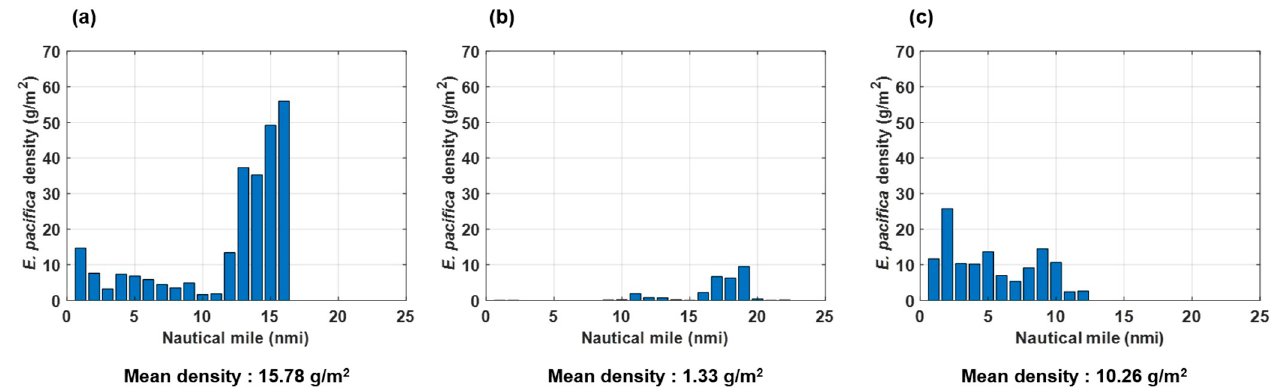
Figure 6. Calculated densities at each nautical mile, and mean density of E. pacifica in the YSBCW at ( a ) Transect 1, ( b ) Transect 2, and ( c ) Transect 3 .